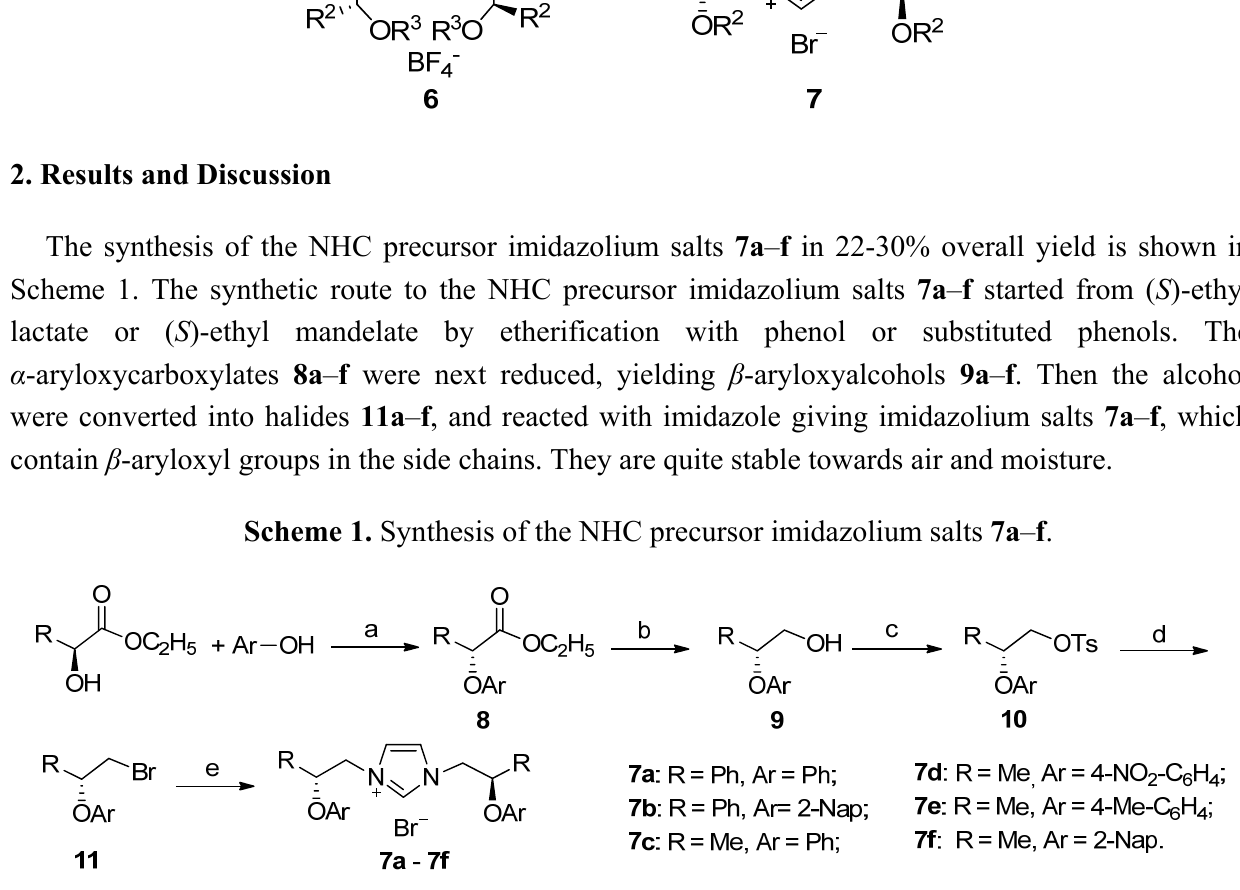
Figure 2. The structure of tridentate C